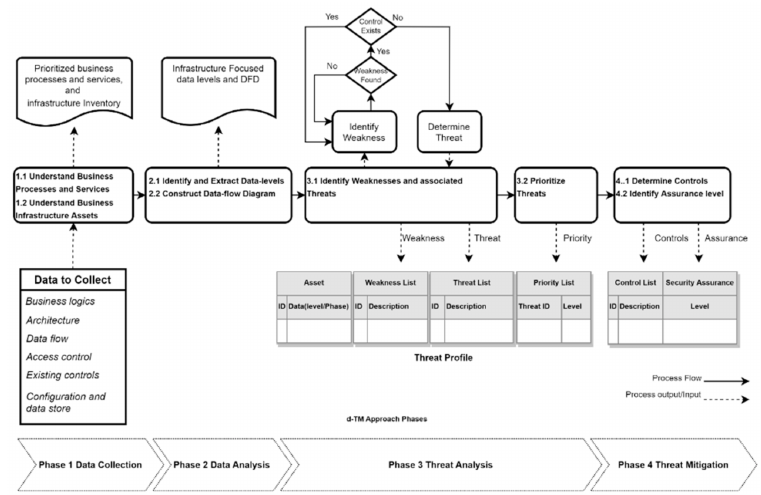
Figure 2. An overview diagram of the Data-driven threats analysis